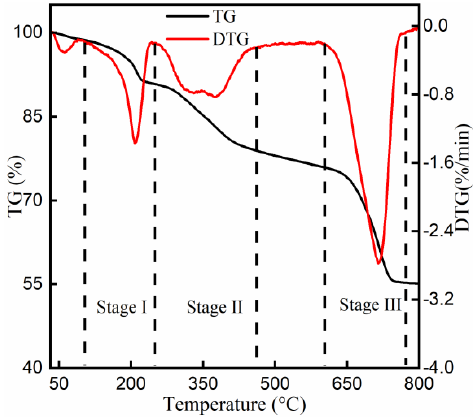
Figure 3. TG/DTG profiles of CaMgAl-LDHs.